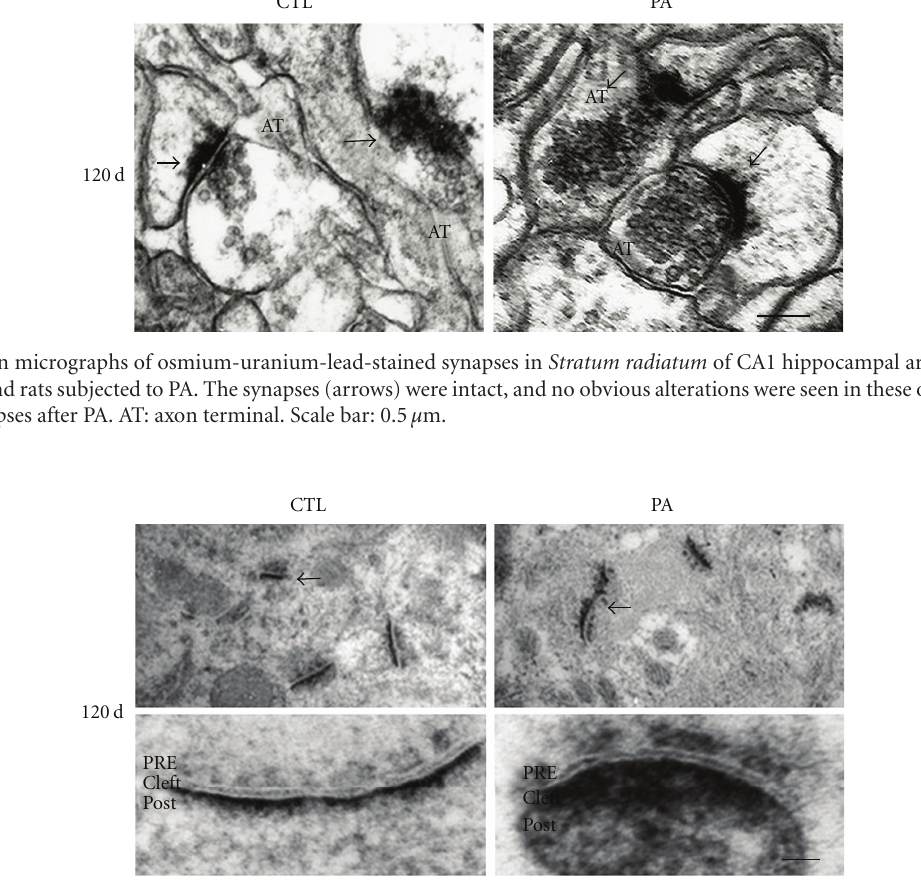
Figure 3: Electron micrographs of E-PTA-stained PSDs (arrows) in Stratum radiatum of CA1 hippocampal tissue section from 4-month-old control rats and rats subjected to 19min of PA. Note the increased thickness and dispersed appearance of the PSDs in the asphyctic brains, compared with the control. Scale bar: 0.5 μ m. PRE: presynapses; PSD: postsynaptic